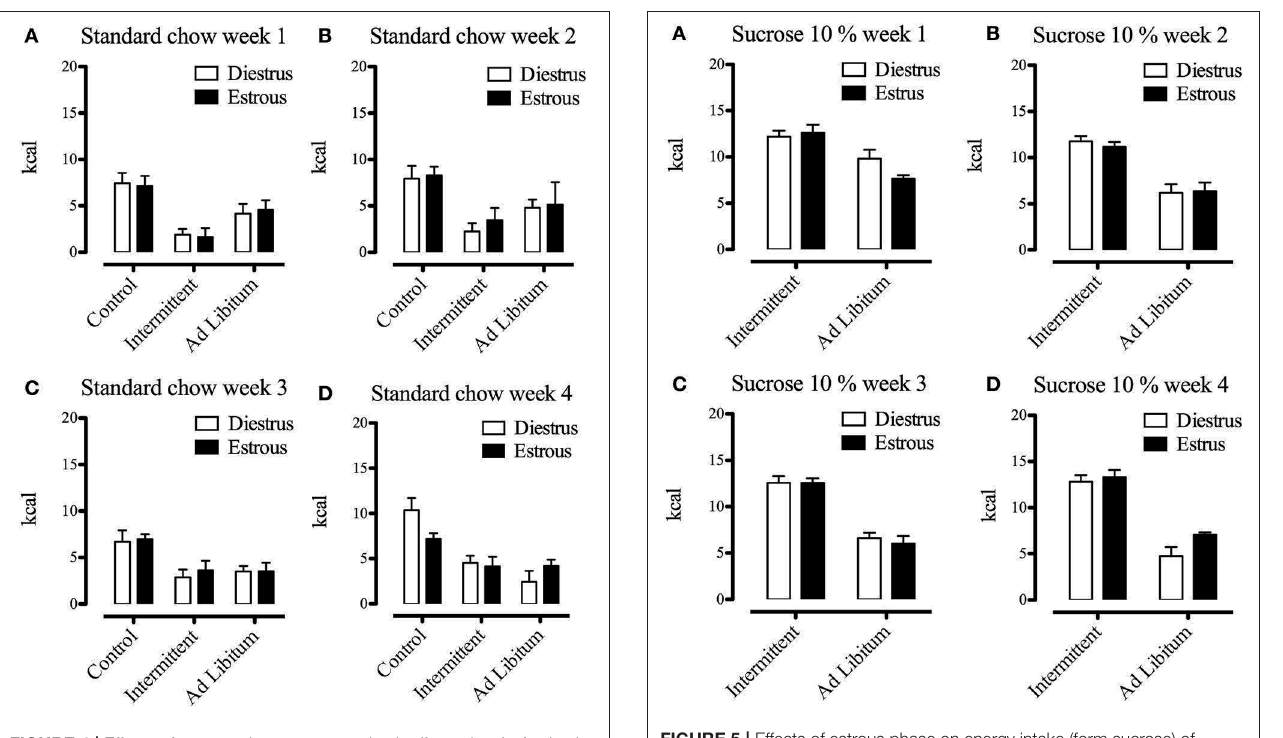
FIGURE 4 | Effects of estrous phase on energy intake (from chow) of animals differentially exposed to the sucrose solution after 1 (A) , 2 (B) , 3 (C) , and 4 (D) weeks from the beginning of the protocol ( n = 7–12). Food intake was measured in grams during a 2-h period, converted to kcal and expressed as means ± S.E.M.